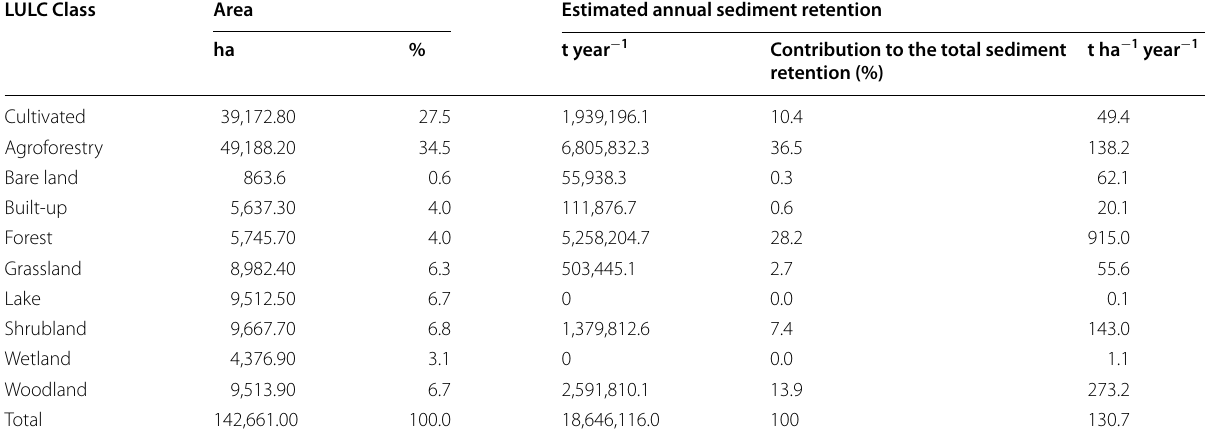
Table 9 Sediment retention by LULC types